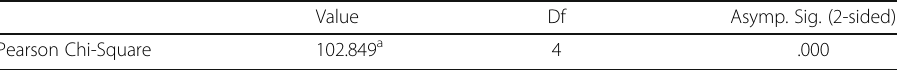
Table 5 Chi-Square analysis of the teachers-learners ’ perceptions towards explicit grammar instruction and corrective feedback Value Df Asymp. Sig. (2-sided) Pearson Chi-Square 102.849 a 4